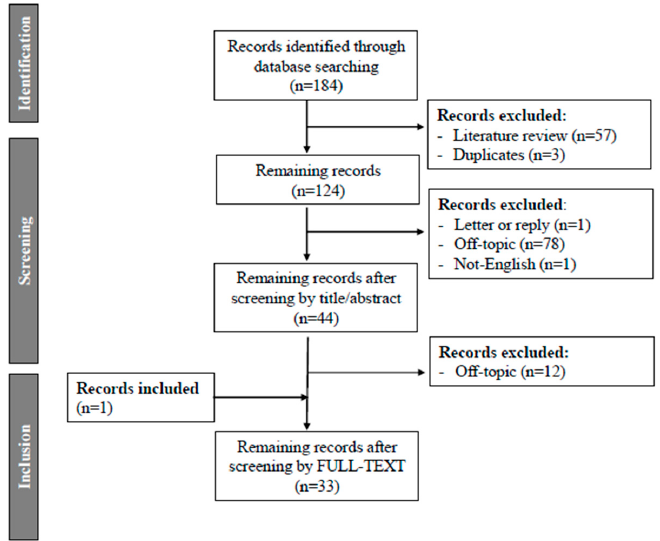
Figure 1. PRISMA flowchart summarizing inclusion of studies in systematic .